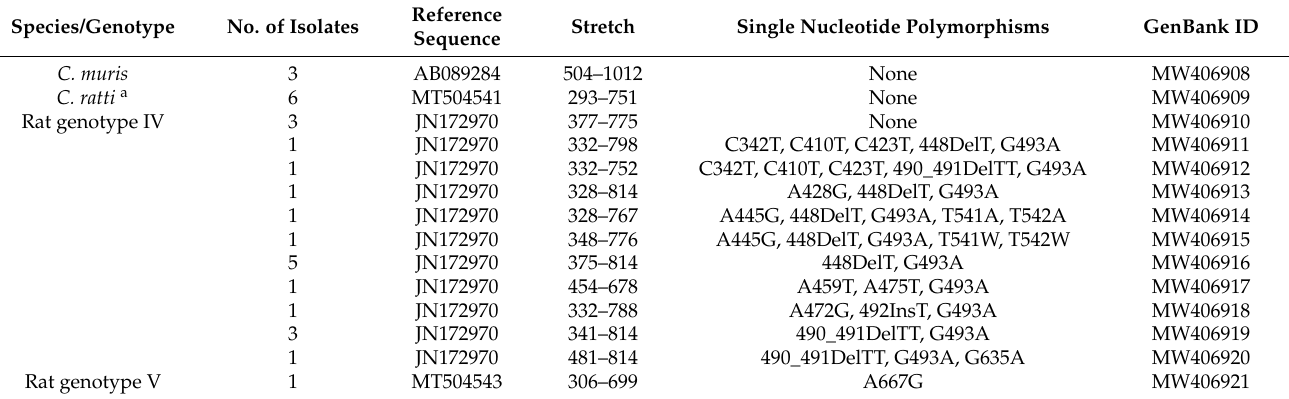
Table 5. Diversity, frequency, and molecular features of Cryptosporidium spp. sequences at the ssu rRNA locus obtained in faecal samples from the rat population under study in C ó rdoba Zoo Conservation Centre (Spain). GenBank accession numbers are